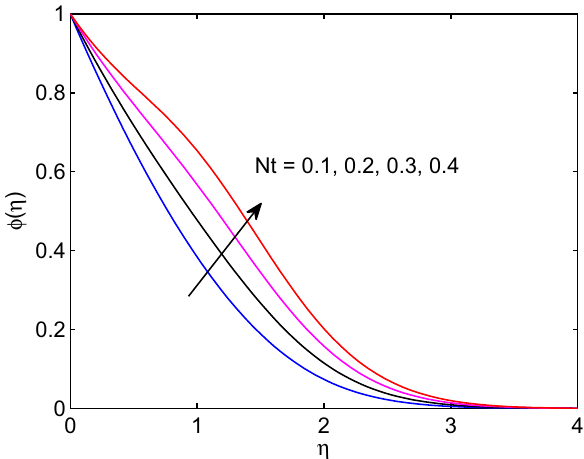
Figure 28. Thermophoresis effects on volumetric concentration profiles.